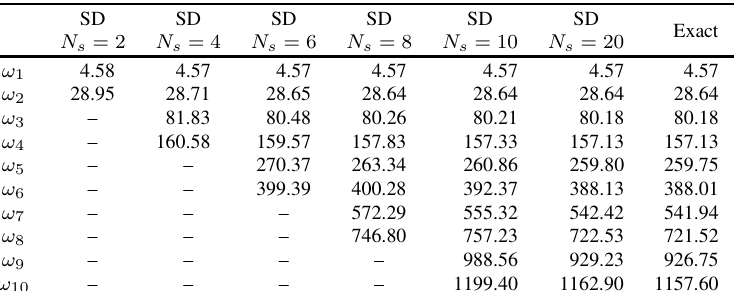
Table 1 Resonance frequencies estimated from